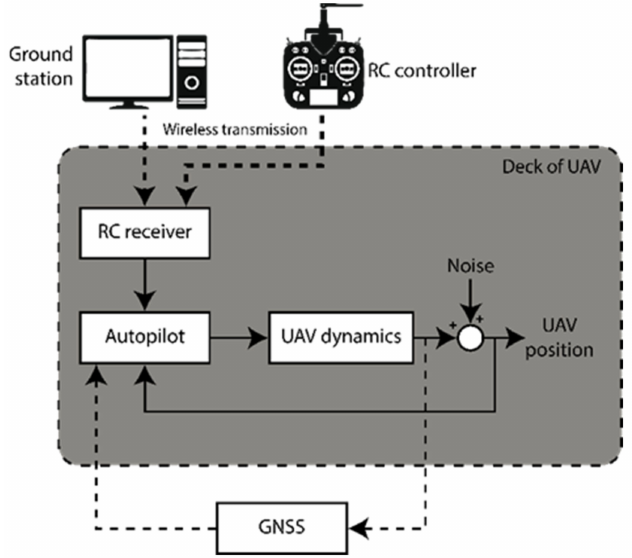
Figure 2. UAV flight control